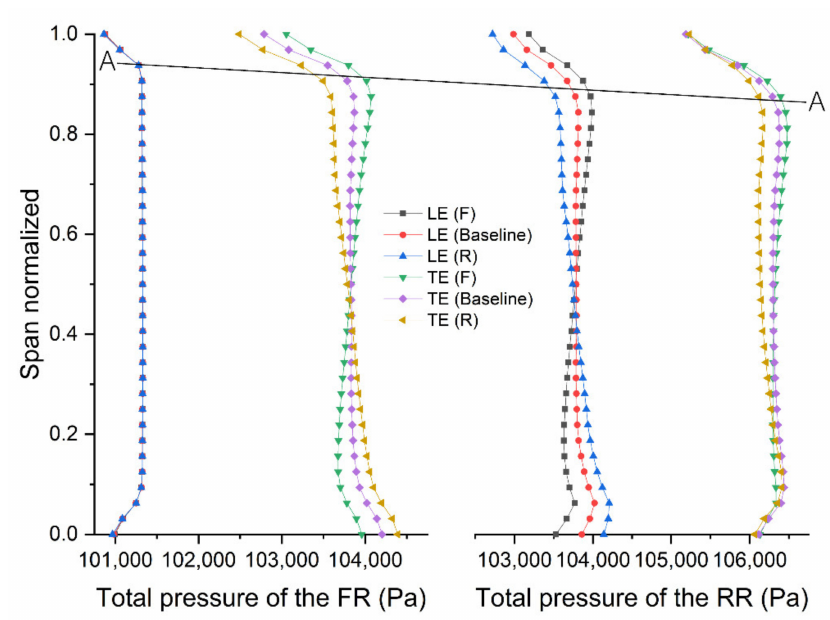
Figure 14. Total pressure at the design